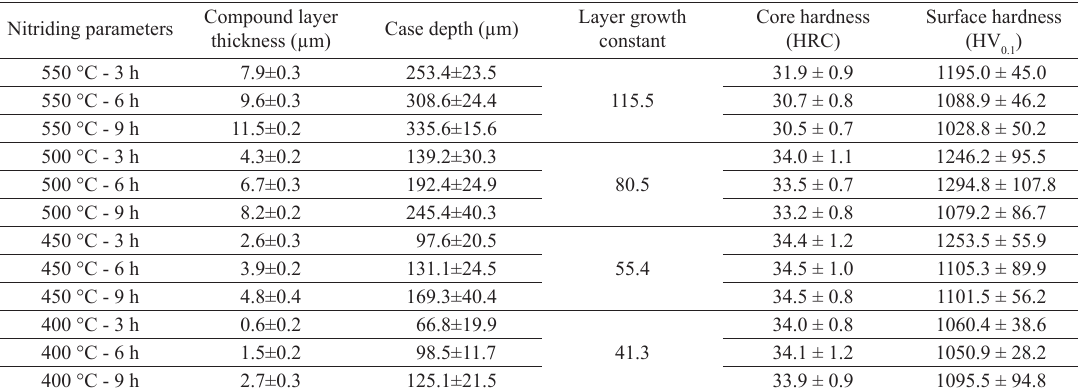
Table 3. Modification of surface/core properties after plasma